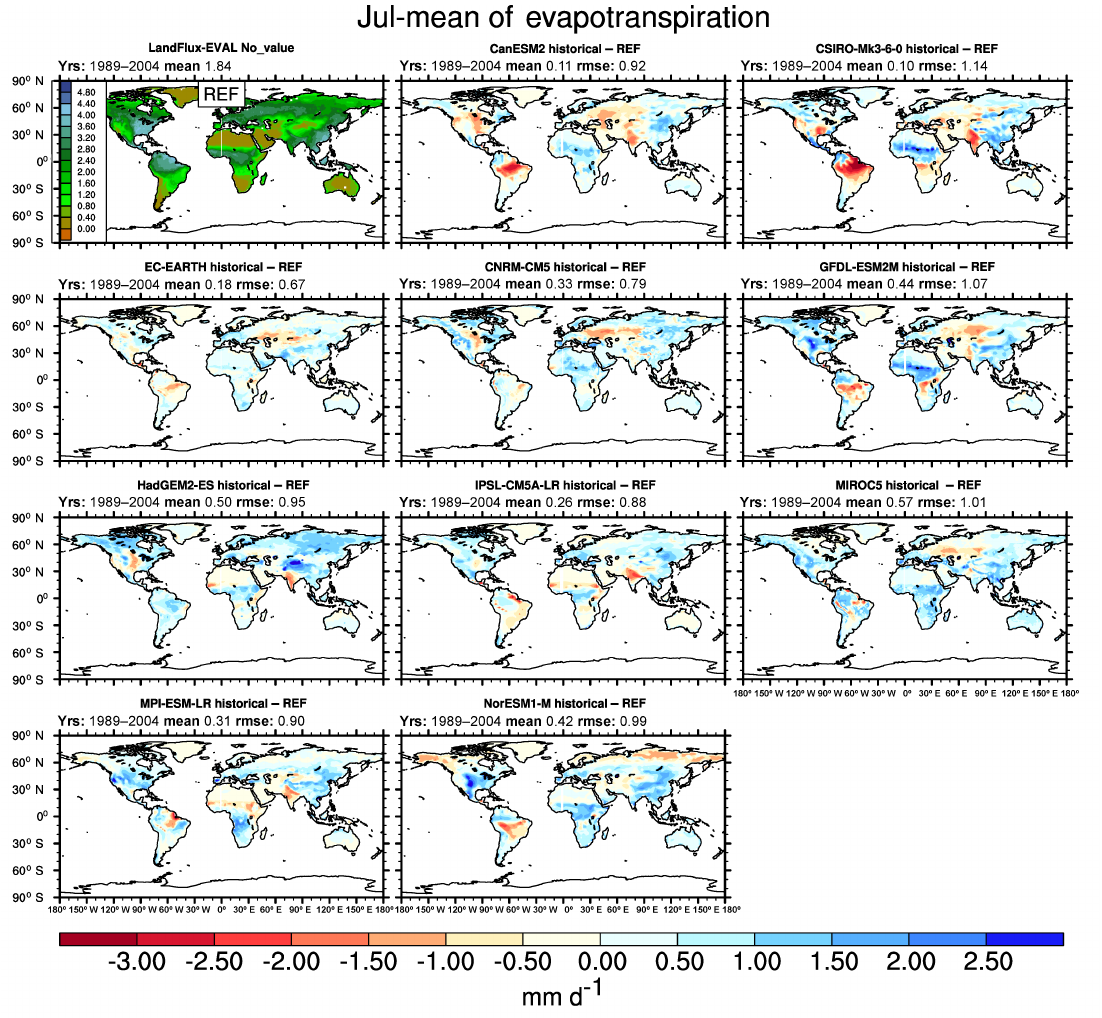
Figure 18. Bias in evapotranspiration (mmday − 1 ) for July in a subset of CMIP5 models in reference to the LandFlux-EVAL evapotranspira- tion product. The global mean bias is also indicated for each model as well as the RMSE. The comparison reveals the existence of biases in July evapotranspiration for a subset of CMIP5 models. All models overestimate evapotranspiration in summer, especially in Europe, Africa, China, Australia, Western North America, and parts of Amazonia. Biases of the opposite sign (underestimation in evapotranspiration) can be seen in some other regions of the world, notably over parts of the tropics. For most regions, there is a clear correlation between biases in evapotranspiration and precipitation (see precipitation bias in Fig. 4). Produced with namelist_Evapotranspiration.xml